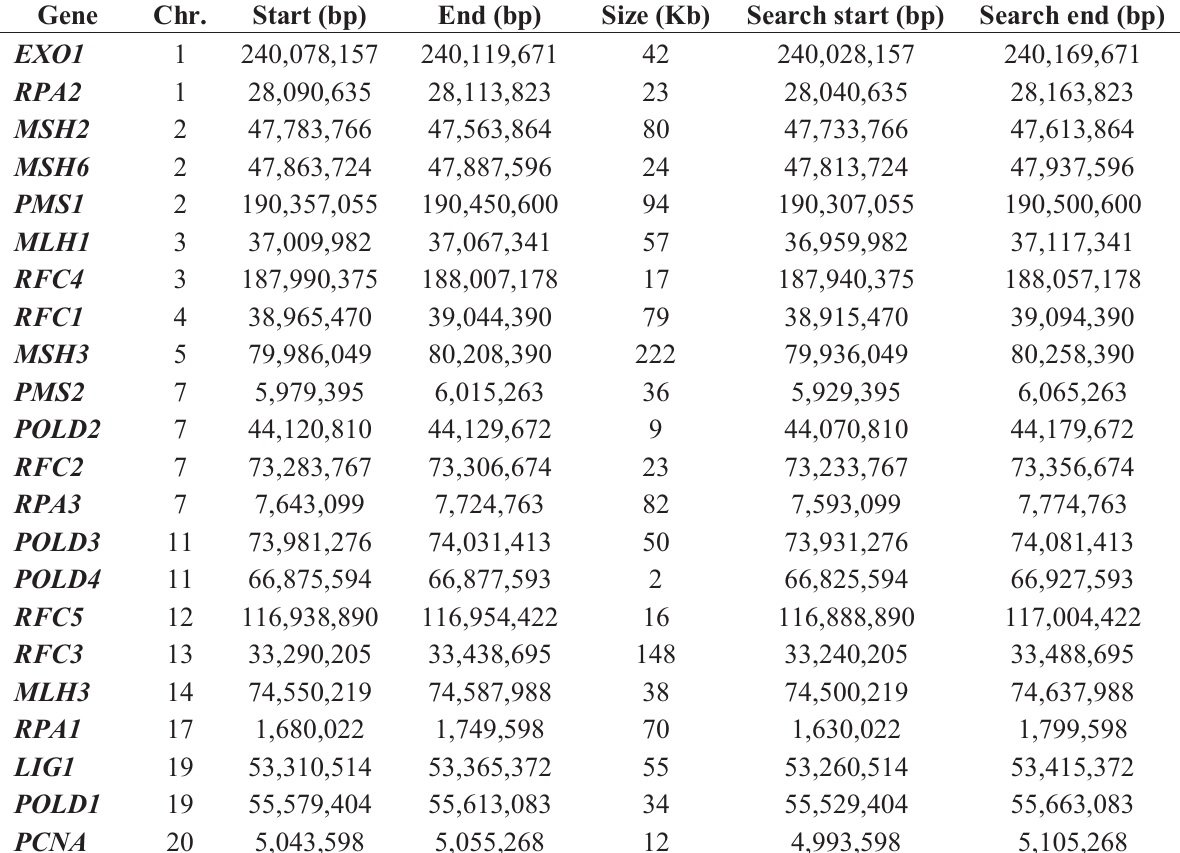
Table 2. Regions searched for CN gains and CN losses in and in the vicinity of (±50 Kb) of the 22 genes in the mismatch repair (MMR) pathway. Chromosomal position of gene (start and end), gene size and search region (search start and search end) is noted. Gene